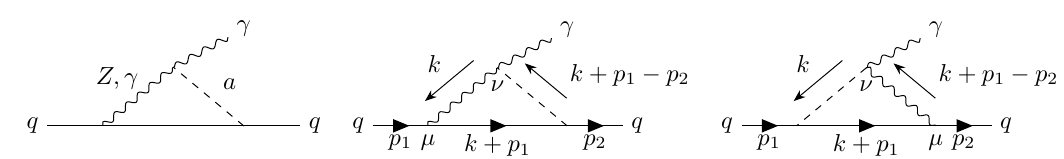
Figure 11 . Barr-Zee diagrams relevant for the quark EDM computation in our UV